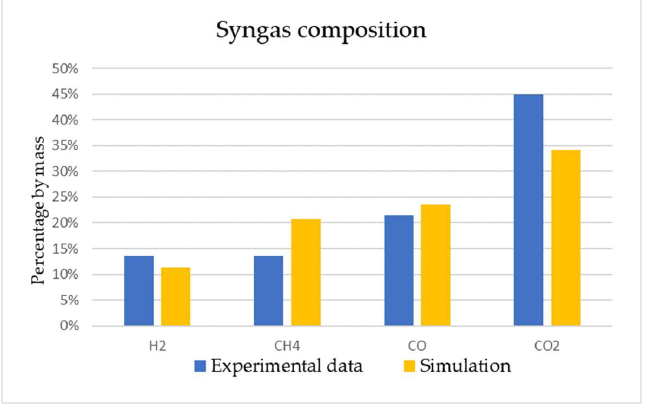
Figure 4. Percentage by mass of the syngas main components.